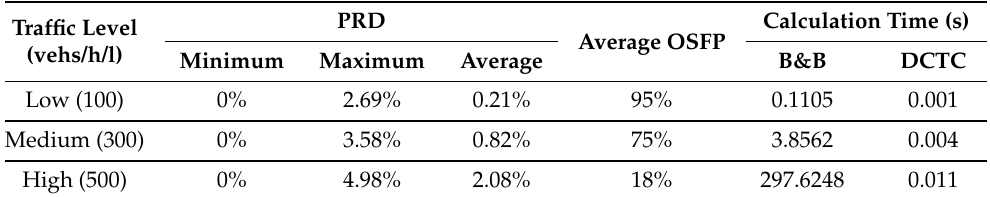
Table 6. Performance comparison between B&B and